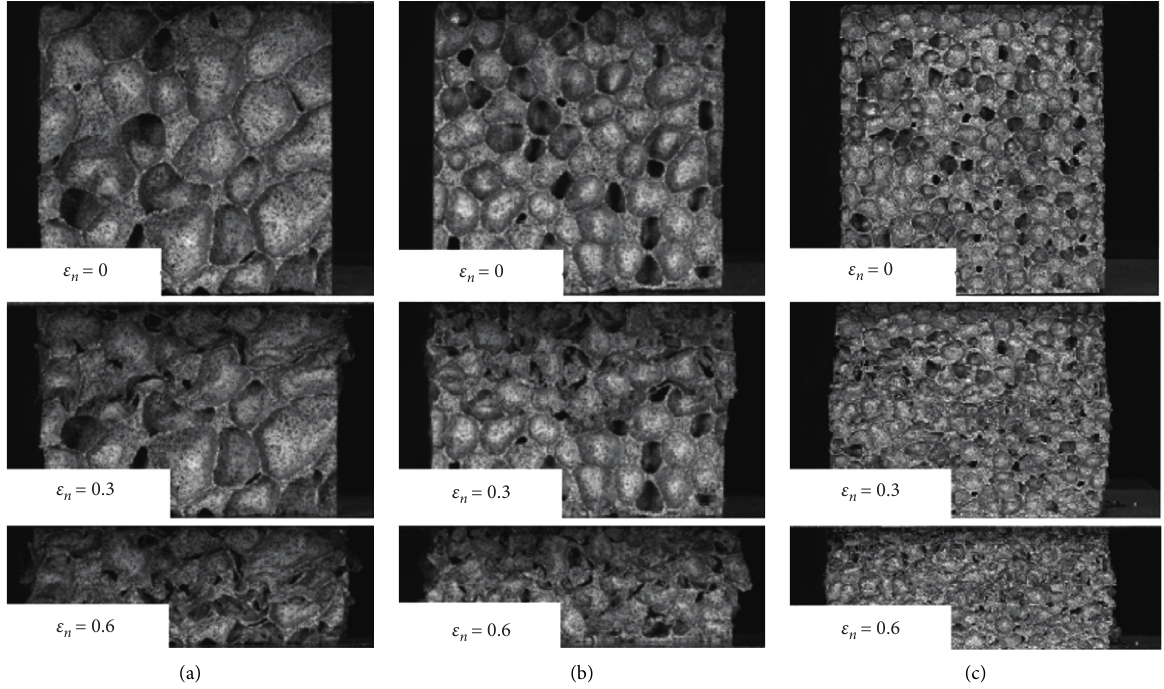
Figure 4: Compression process of the aluminum foam samples. (a) ρ � 0 . 1; (b) ρ � 0 . 15; (c) ρ � 0 . 2.